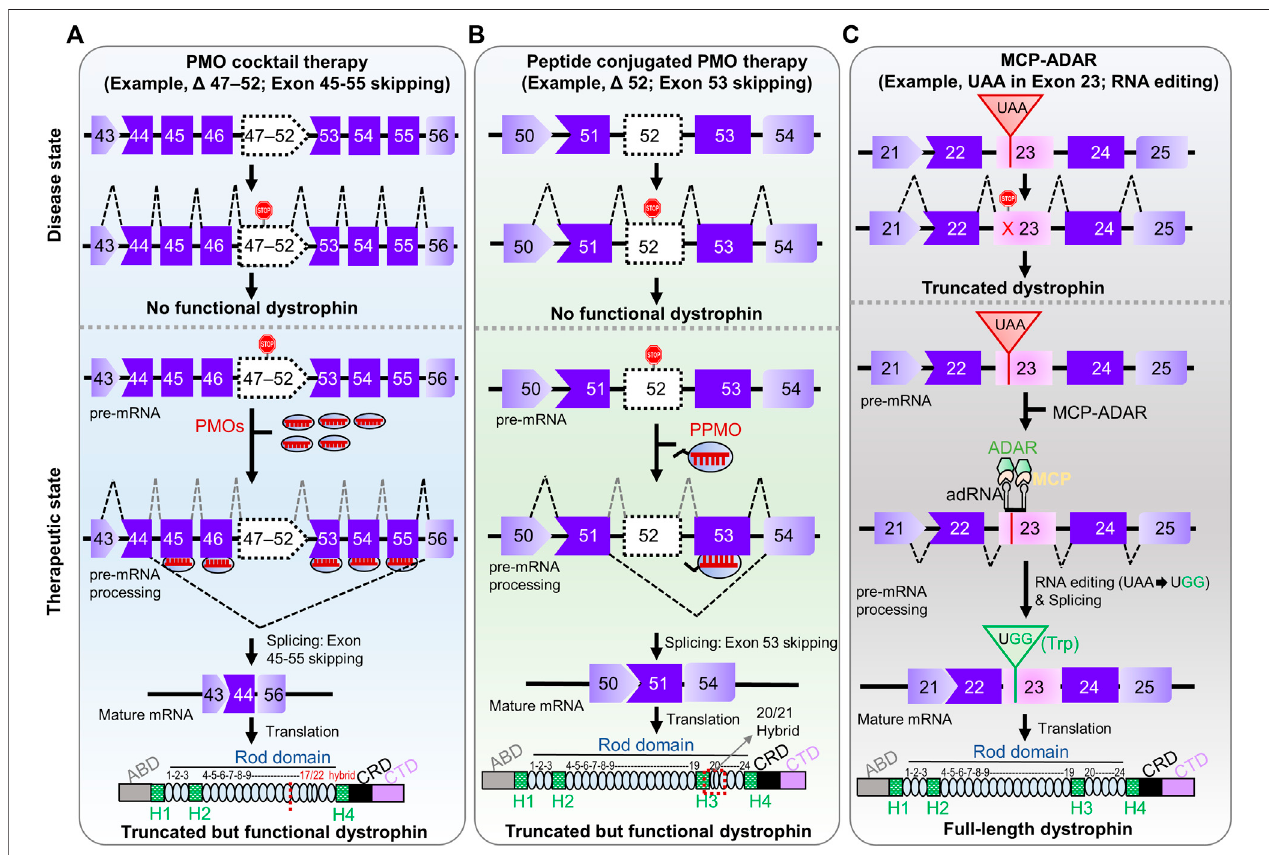
FIGURE 2 | Pre-clinical RNA-manipulation therapies for DMD. (A) PMO cocktail therapy contains multiple PMOs complementary to multiple target exons (exon 45 – 55, a so-called mutation hotspot) amenable to multiple exon-skipping yields truncated but preserved function. (B) Peptide-conjugated PMO therapy involves conjugation of a cell-penetration peptide to the morpholino ASO targeting an exon. The ultimate fate of exon skipping in dystrophin structure is shown in each panel; ABD, Actin binding domain; H1-H4, Hinge domains; Rod domain contains 24 domains; CRD, Cysteine-rich domain; CTD, C-terminal domain. (C) MCP-ADAR therapeutic strategy uses ADAR enzyme fused to MS2-coat protein to convert a stop codon (UAA) into a read-through codon (UGG; Trp) and produces a full-length dystrophin.